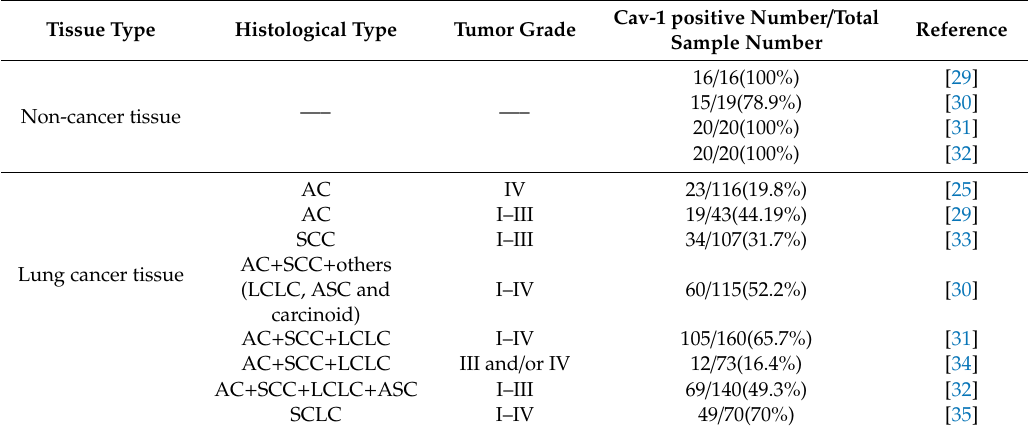
Table 1. The diversity of Cav-1 expression in non-cancer tissues and lung cancer tissues of di ff erent grades and